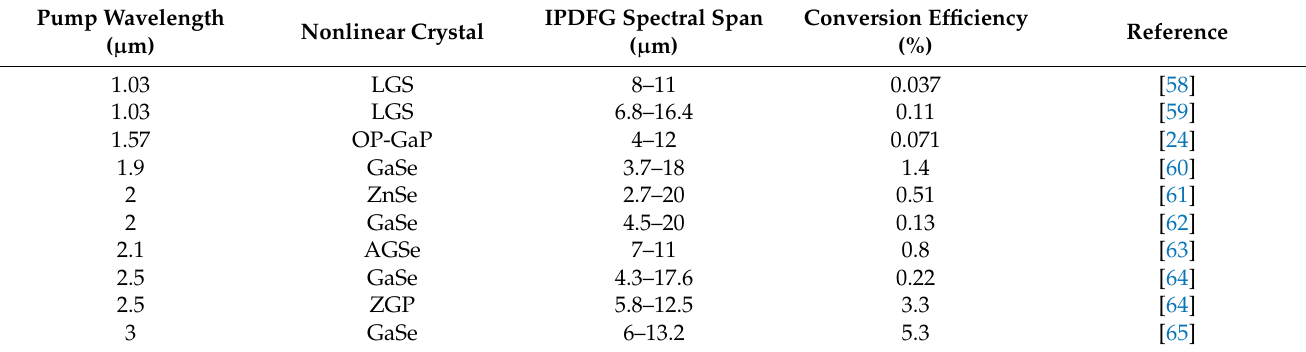
Table 5. Parameters of selected IPDFG source.